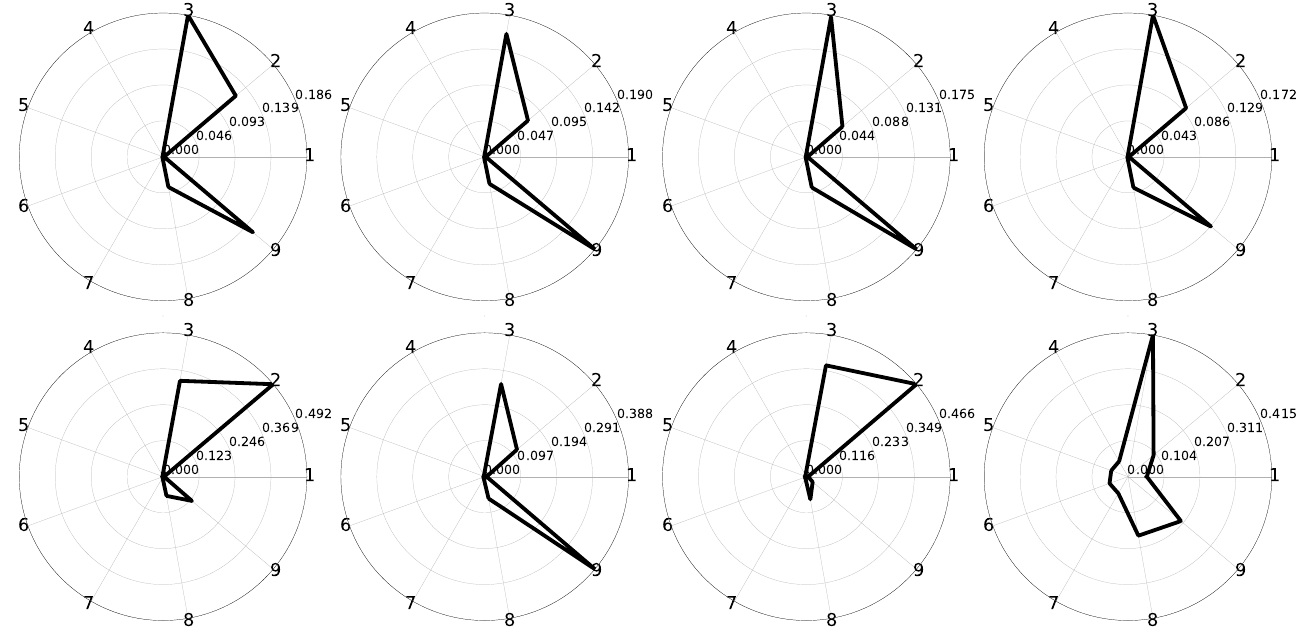
Figure 16. LSTMAE loss signatures per cooling unit for false negatives ( top ) and false positives ( bottom ). After analysis with the help of the airline, false negatives can be generally explained by weak or short-lived faulty signatures. Even for the airline experts, it was difficult sometimes to detect a clear faulty signature when looking at some of the signal plots. Another explanation could be the uncertainty on the labelling of health status, especially for the flights with incipient faults in the beginning of the failure period. This is